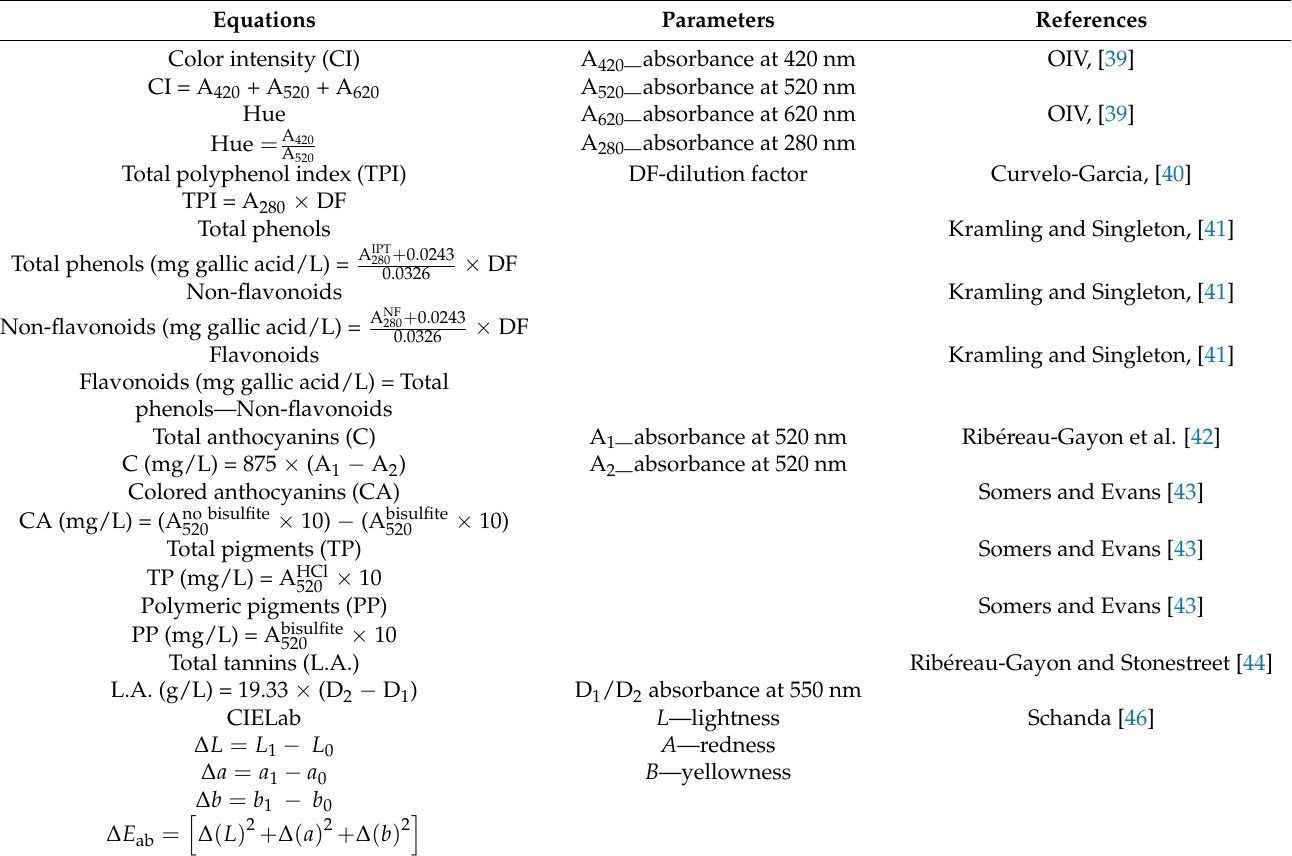
Table 2. Equations for phenolic composition and chromatic (CIELab) determination [38].